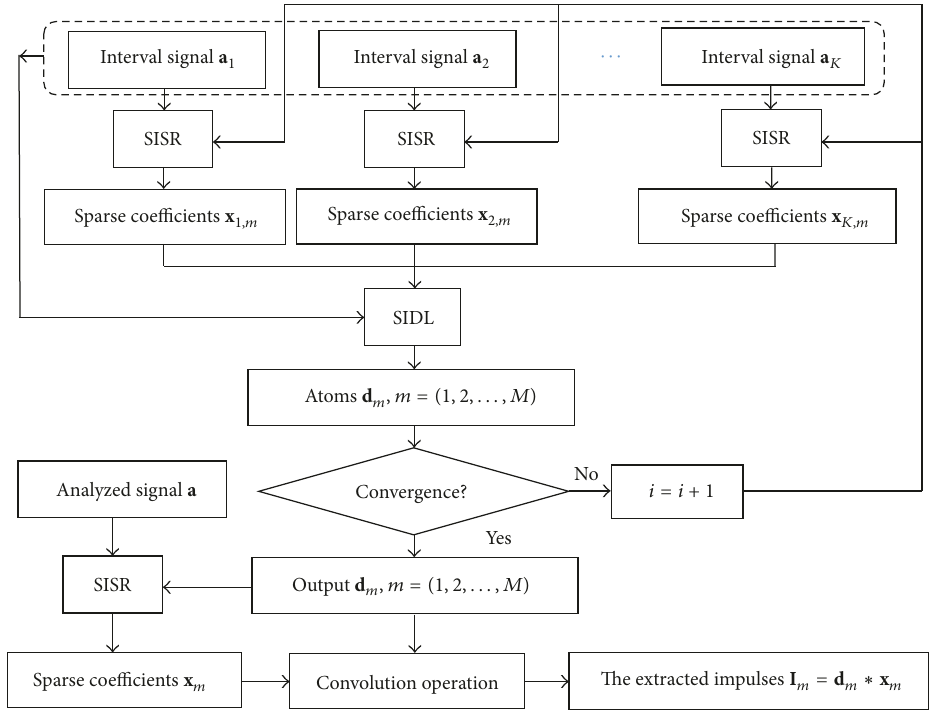
Figure 1: The procedure of extracting the